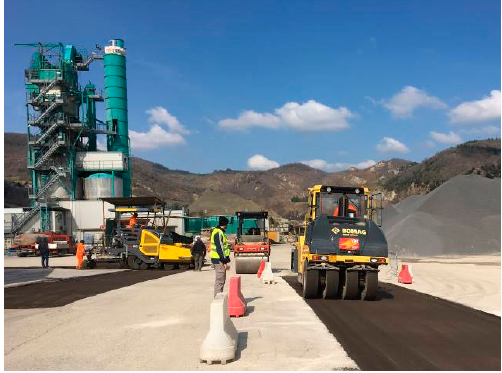
Figure 6. Compaction of CRAM binder course of Subsection C by using the 22-ton pneumatic-tired roller.